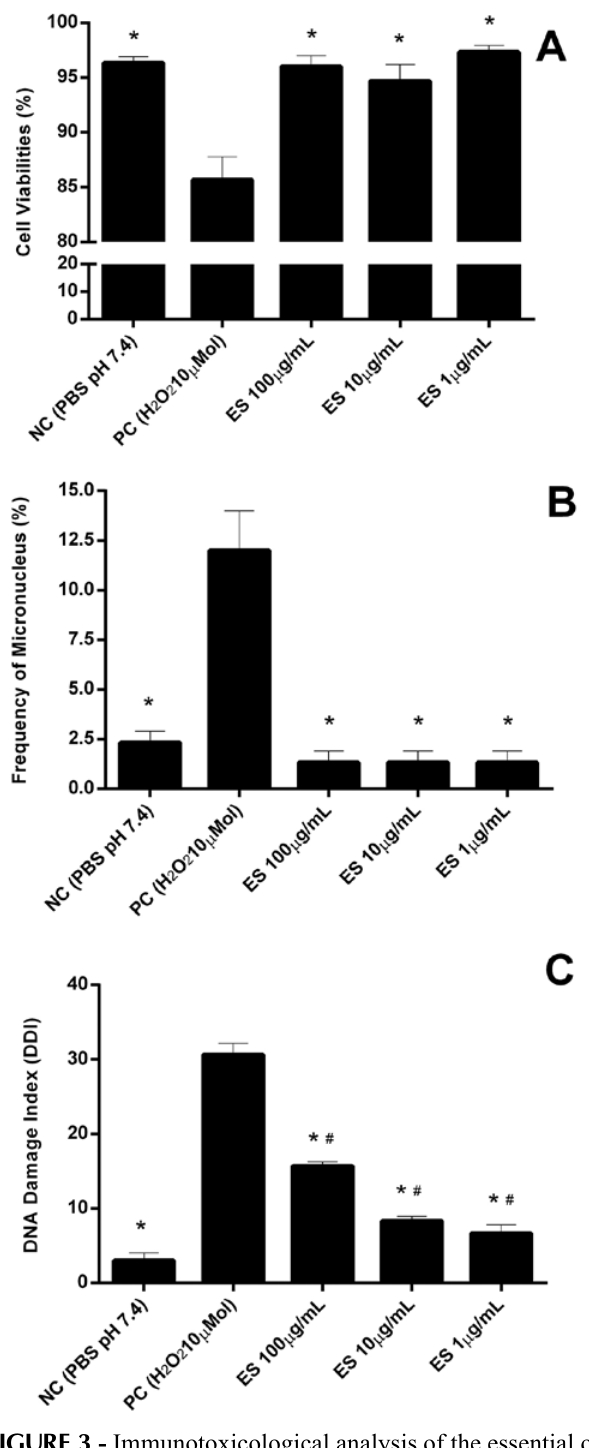
FIGURE 3 - Immunotoxicological analysis of the essential oil treatment of Eugenia sulcata leaves (1, 10, and 100 µg/mL) on human lymphocytes. Legend: Eugenia sulcata (ES), negative control with phosphate buffer (PBS) (NC), positive O ) (PC). (A) Cell viability control with hydrogen peroxide (H 2 2 assessment. (B) Evaluation of DNA damage index by comet assay. (C) Micronucleus frequency evaluation. * p<0.05 vs PC and # p<0.05 vs NC.